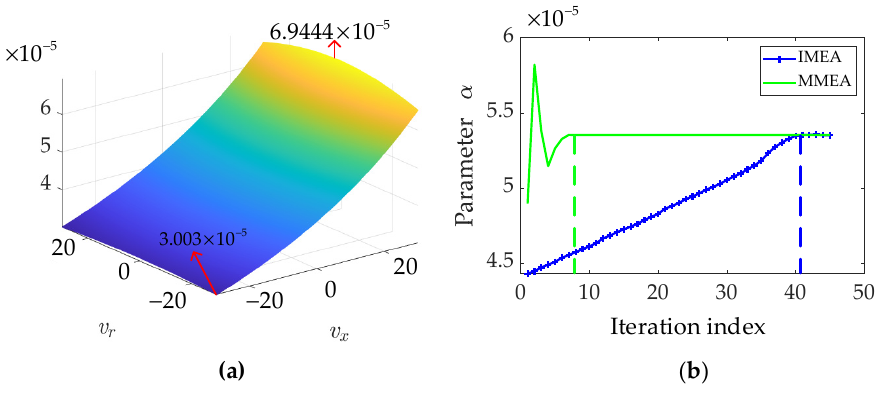
Figure 9. ( a ) Parameter value range; ( b ) The GMT parameter iteration graph of MMEA and IMEA. Compensate the residual phase error of the GMT defocused image, we get the GMT focused image and sparse enhancement image with or without spectrum rotation, which is shown in Figure 10. In Figure 10a, the focused GMT image without spectrum rotation has severe geometry distortion that the point-like GMT turns into ellipse-like GMT.